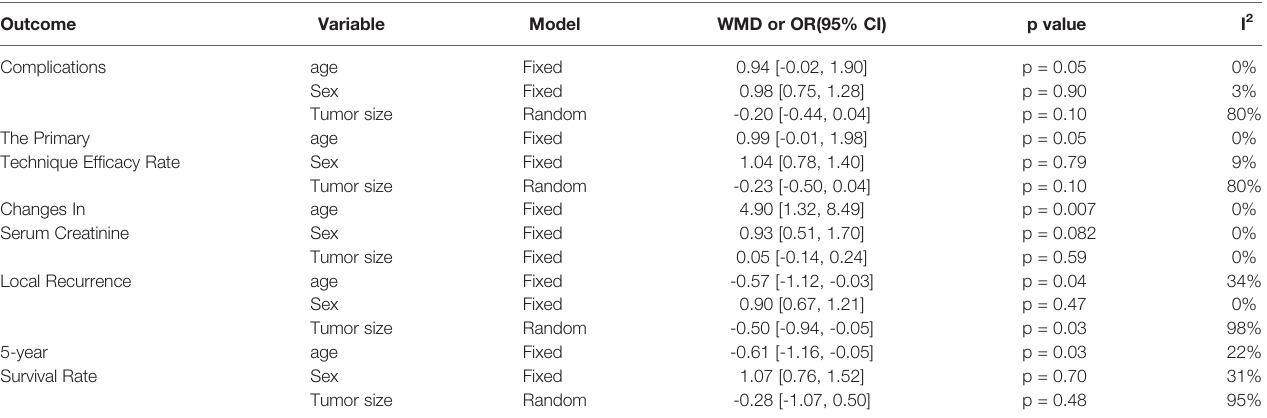
TABLE 2 | The demographics of the